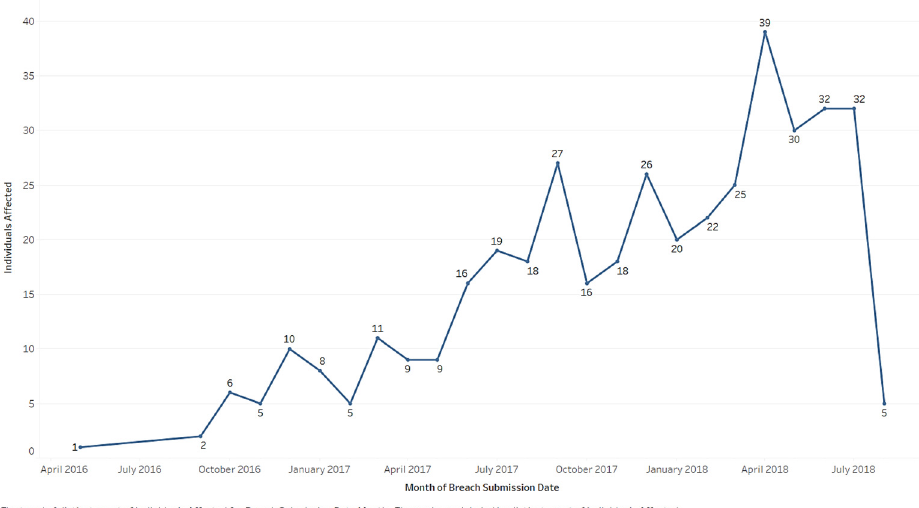
Figure 10. Number of breach records trend.